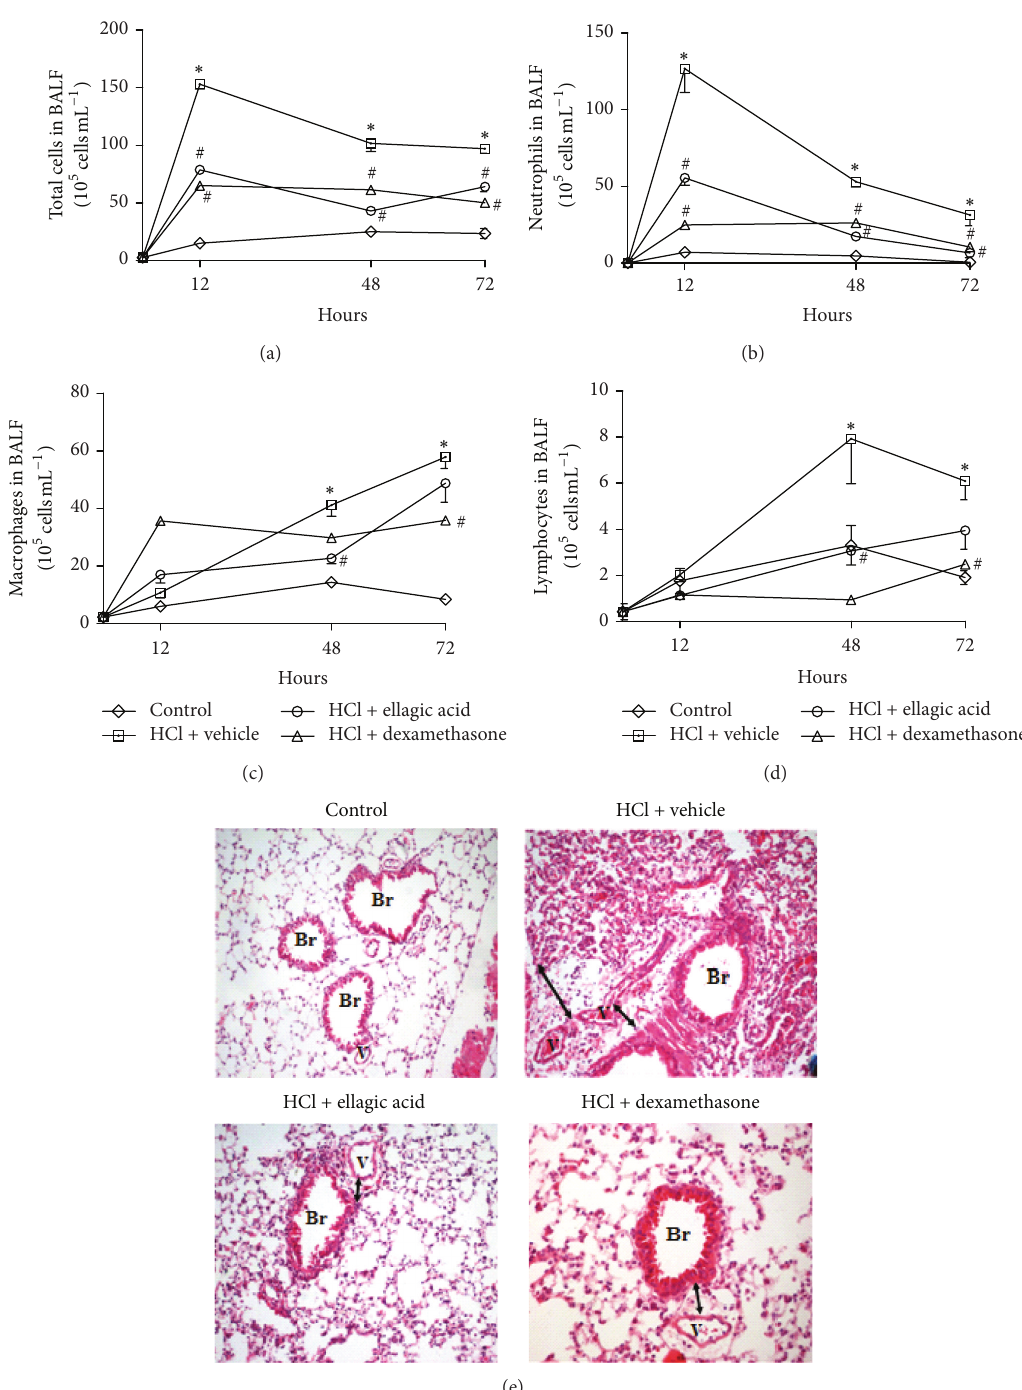
Figure 1: Ellagic acid prevents the development of airway inflammatory responses in the experimental model acid-initiated acute lung injury. Mice received ellagic acid (10mg/kg, p.o.), dexamethasone (1mg/kg, s.c.), or vehicle (water, p.o.) 30 minutes prior and/or after (24, 47, and/or 71h) the acid intratracheal instillation into the left lung (see Methods). The kinetics of inflammation was determined at 12, 48, and 72 hours after acid-initiated acute lung injury. (a) Total cells, (b) neutrophils, (c) macrophages, and (d) lymphocytes were evaluated in the BALF. One group of animals received saline intratracheal instillation (control group). (e) Lung tissue inflammation was assessed by hematoxylin and eosin staining (H&E, original magnification, 200x). Results represent the mean ± SEM of two or more independent experiments with three mice per group per experiment . ∗ 𝑃 < 0.05 compared with control group; # 𝑃 < 0.05 compared with HCl + vehicle group. Br: bronchus; V: